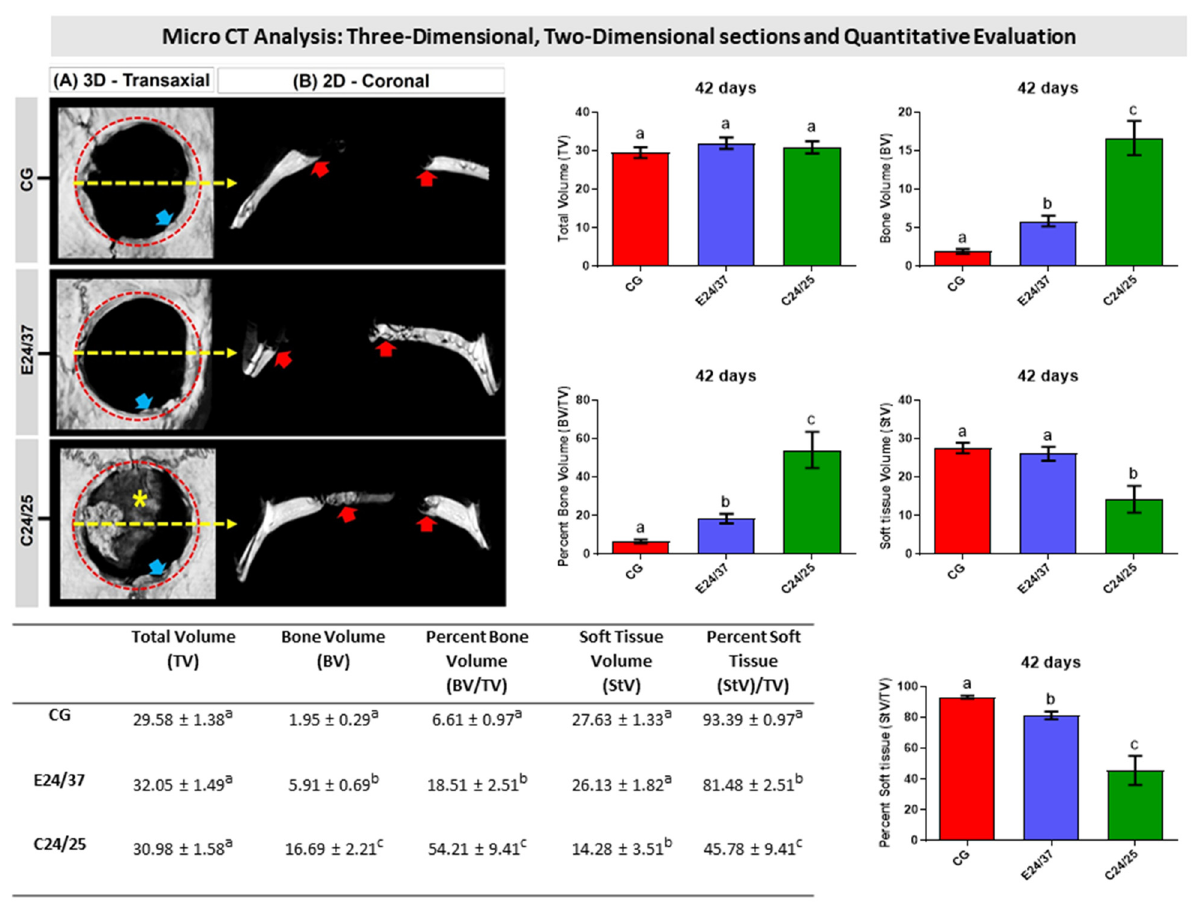
Figure 2. Three-dimensional and two-dimensional reconstructed micro-CT images of rat calvarial bone defects after 42 days, 3D—transaxial and 2D—coronal views of reconstructed images, ( A , B , respectively). Defect without treatment (Control Group); defect filled with hydrolyzed elastin matrix for 24 h at 37 ◦ C (E24/37 Group); defect filled with collagen matrix derived from hydrolyzed porcine intestinal serosa at 24 h at 25 ◦ C (C24/25 Group). All groups showed a centripetal pattern of bone formation, evidenced by increased hyperdensity on the sides of the bone defect (red arrow—see dashed circle identifying the remaining bone), and thin bone plate under the dura mater in C24/25—scaffold (asterisk), remodeling areas (blue arrow) observed in margins of the remaining bone with less hyperdensity and central area of the hypodense defect. Graphs and table representing the quantitative results of the micro CT referring to Total Volume (TV, mm 3 ), Bone Volume (BV, mm 3 ), Percent Bone Volume (BV/TV, %), Soft tissue Volume (StV, mm 3 ) and Percent Soft Tissue (StV/TV, %). In table and histogram, different lowercase letters indicate a significant difference between groups (a (cid:54) = b (cid:54) =